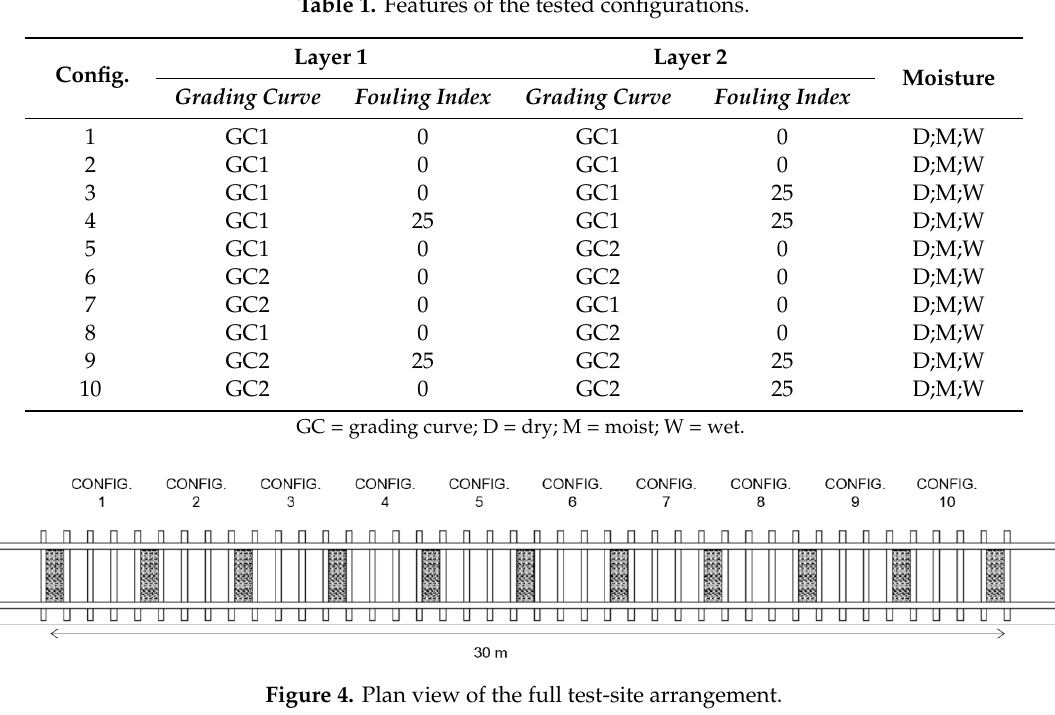
Figure 4. Plan view of the full test-site arrangement.